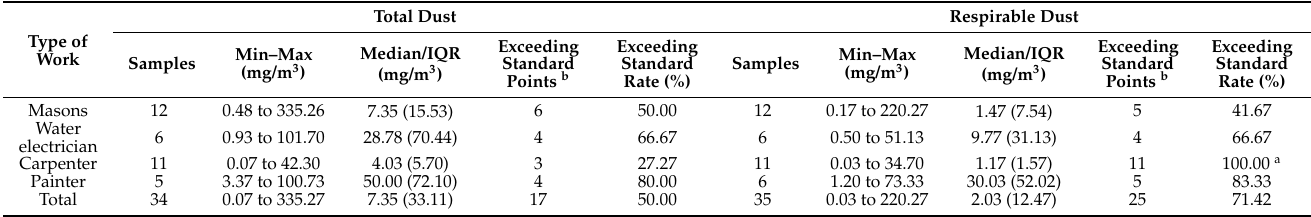
Figure 1. Dust detection carried out in the interior construction site. Table 1. Dust exposure and exceeding standard of different types of